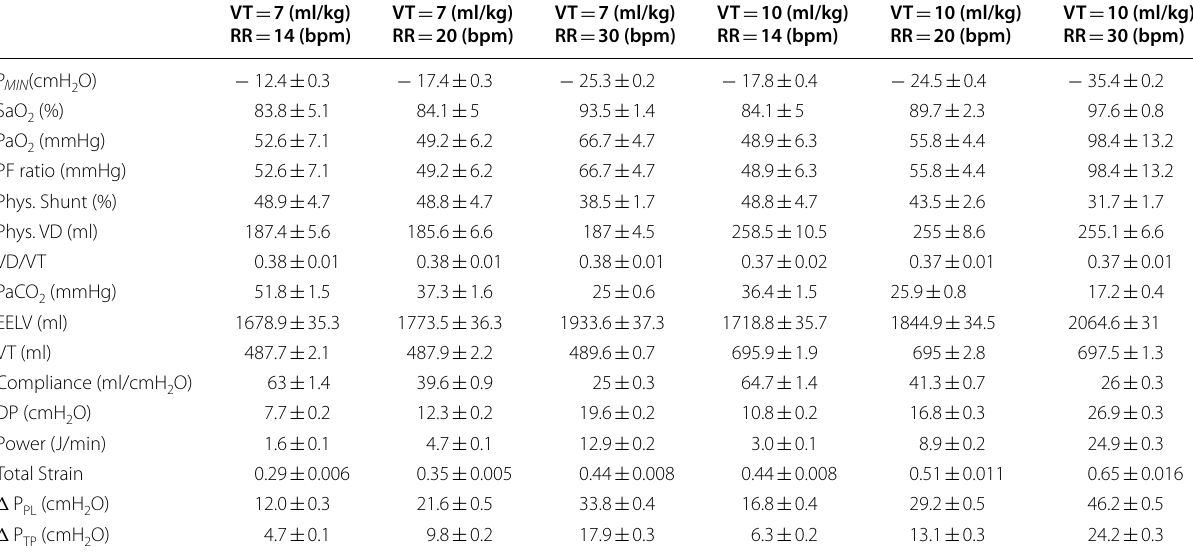
sd across the population of 10 ±